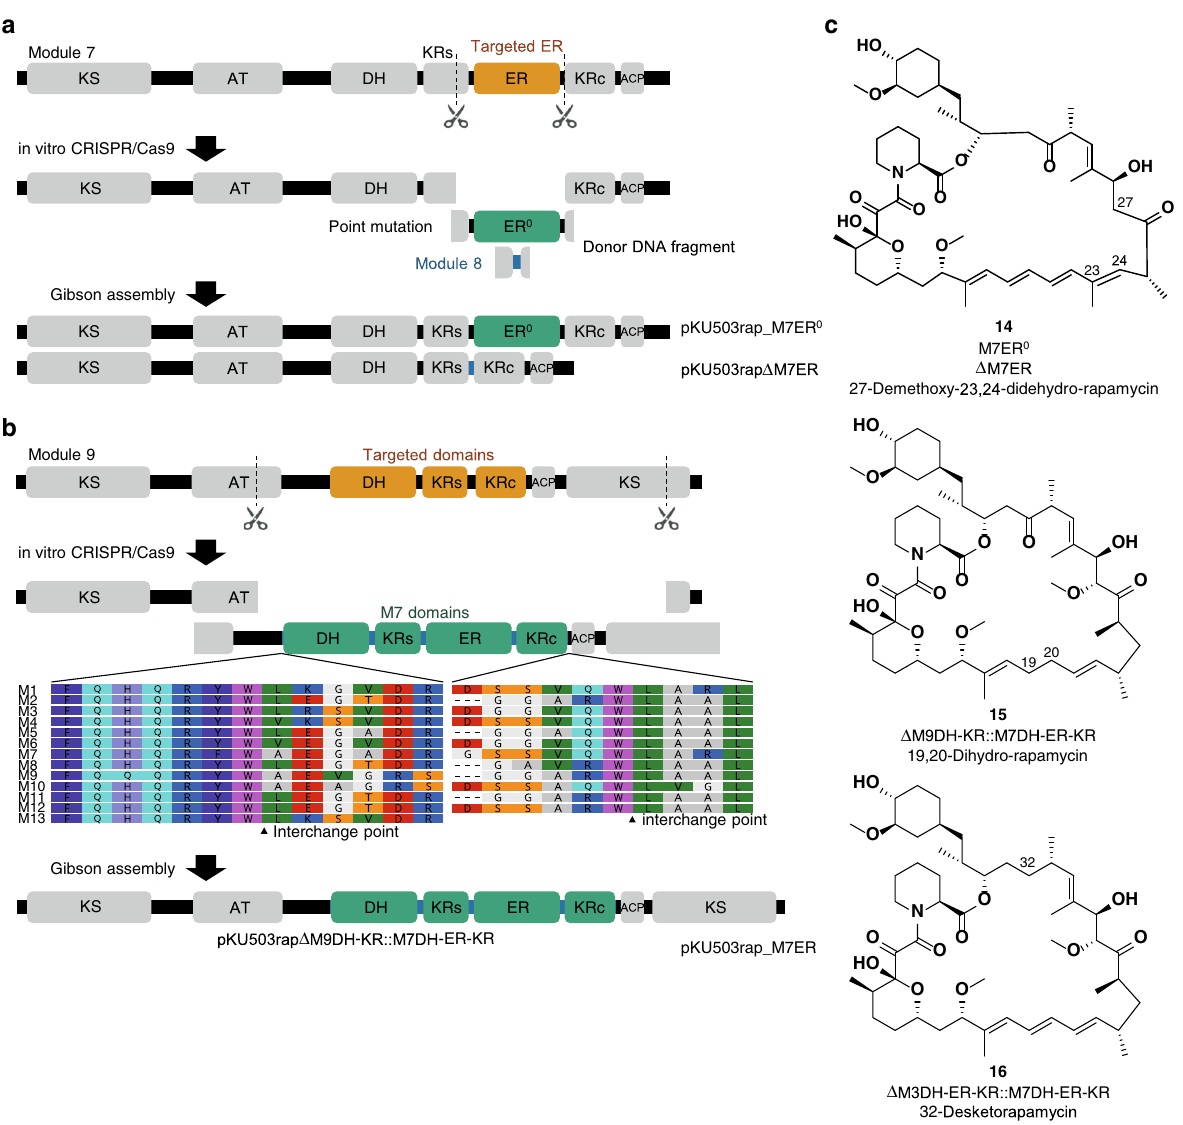
Fig. 3 Schematic representation of the swapping of the reductive loop domains. a Constructions of the ER-inactivation and ER-deletion mutants. b Construction of the reductive loop-swapped mutant. c Structures of the rapamycin derivatives produced in this